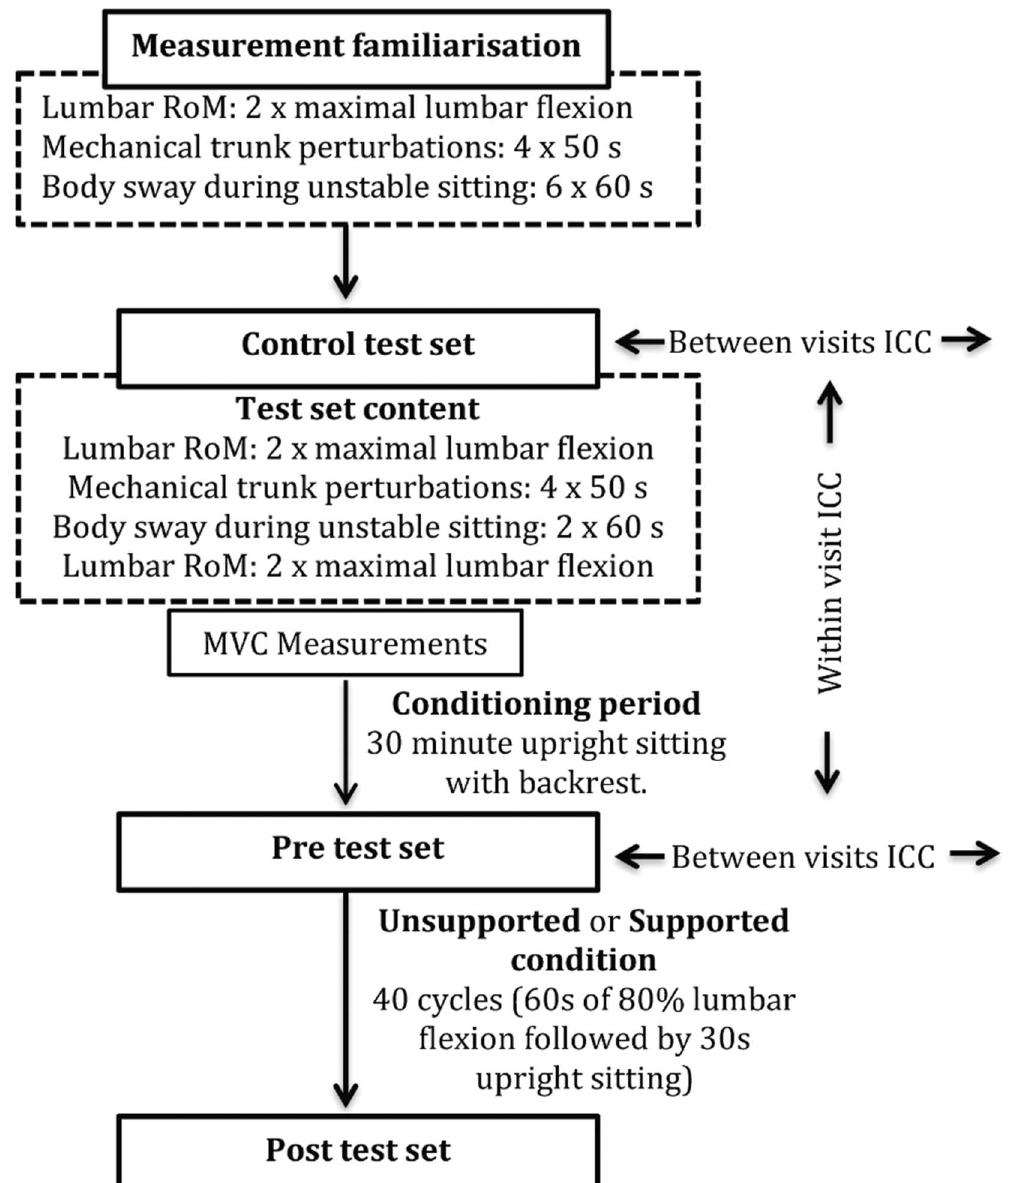
Fig 1. Flow chart presentation of the measurements. Each of the two visits containedthe same testing protocol with the sole difference being the flexion (i.e. intervention) condition.Measurements of body sway during sitting on unstable surface were done but are not includedin the